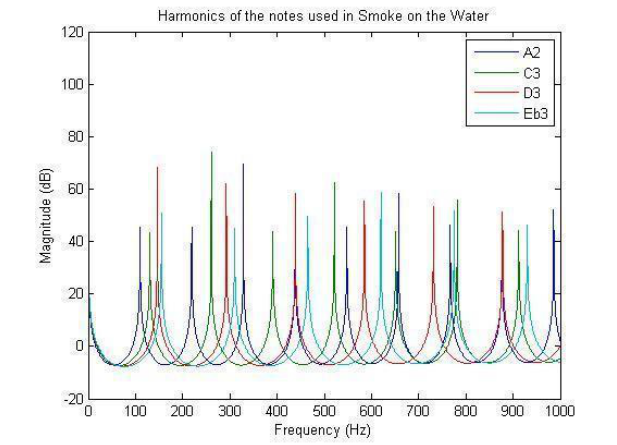
Figure 5 . Harmonics of the notes used in 'Smoke on the